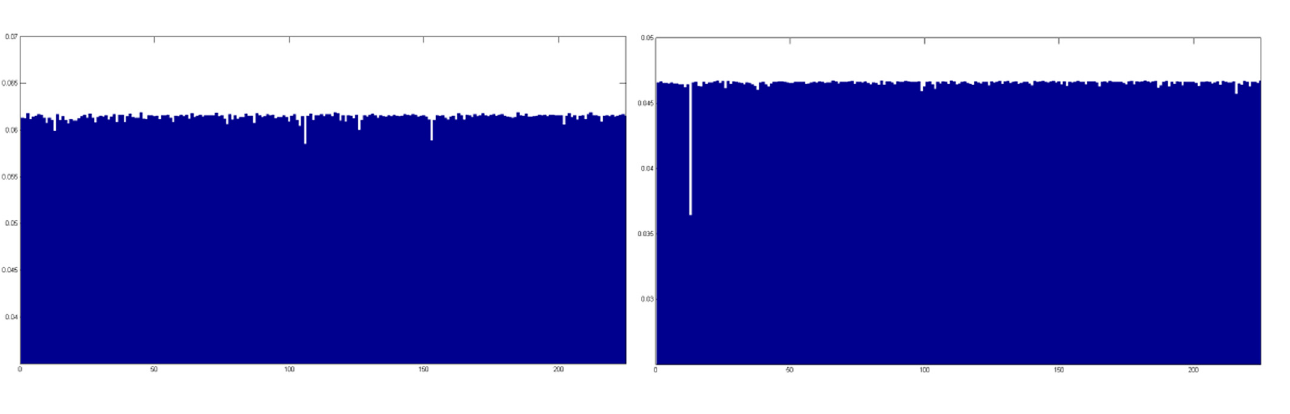
Fig 8. Example of reconstruction residuals of Case 3. (a) 2D texture image. (b) 3D range image.